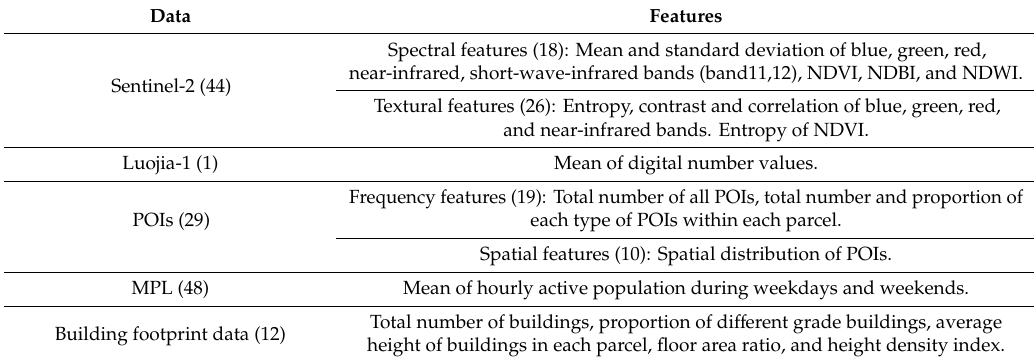
Table 2. Features extracted from multi-source big data. The figure in brackets is the number of